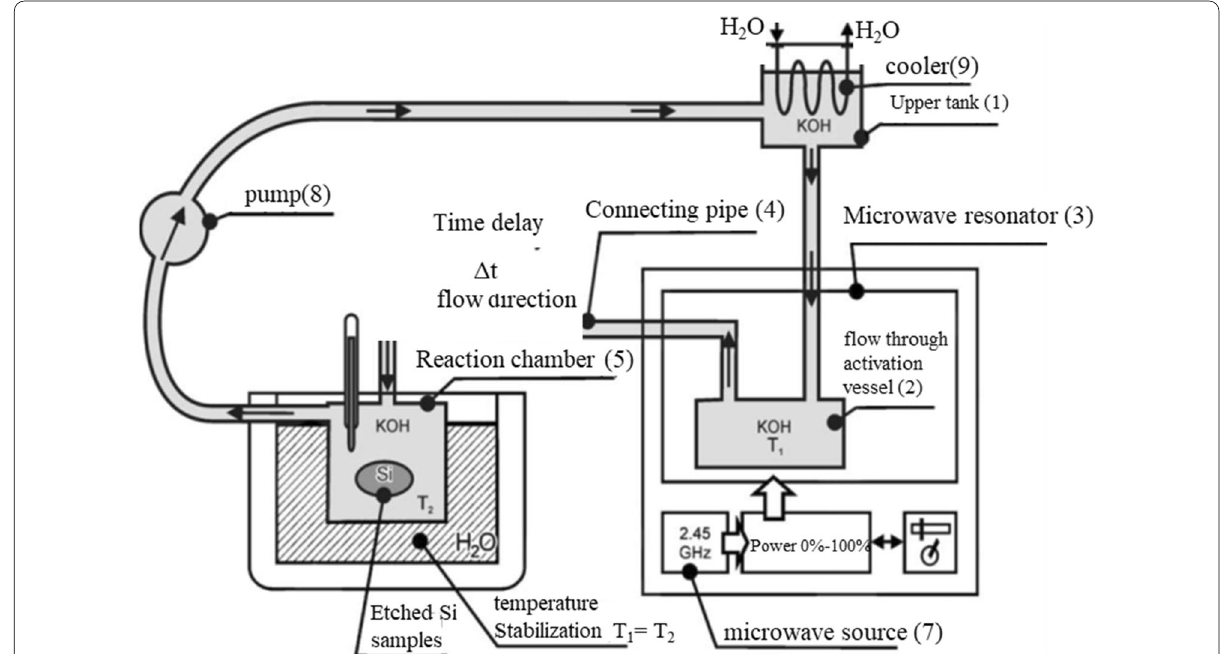
Fig. 13 Experimental set-up of the modified E2MSi stand with closed loop etchant circulation, where etching chamber is separated from solution agitation chamber [84], © 2004, Elsevier